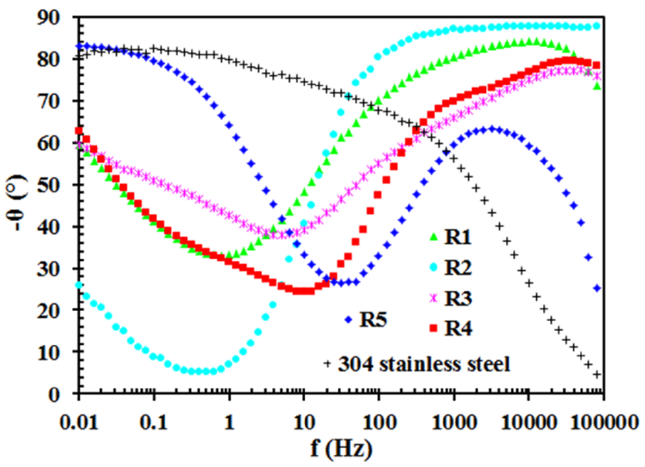
Figure 5. Bode plots (phase angle vs. frequency) of 304 stainless steel and samples